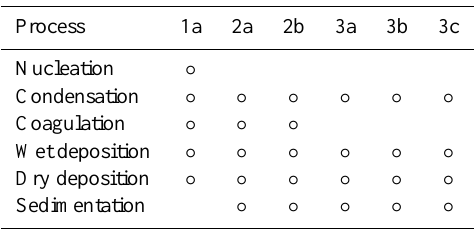
Table 3. Compound distribution in the three subranges. Charac- ters a–c after subrange indicator refer to parallel subranges for dif- ferent chemical compositions. In subrange 3 the number concen- tration is assumed to consist in solely seasalt or dust (marked with [ ◦